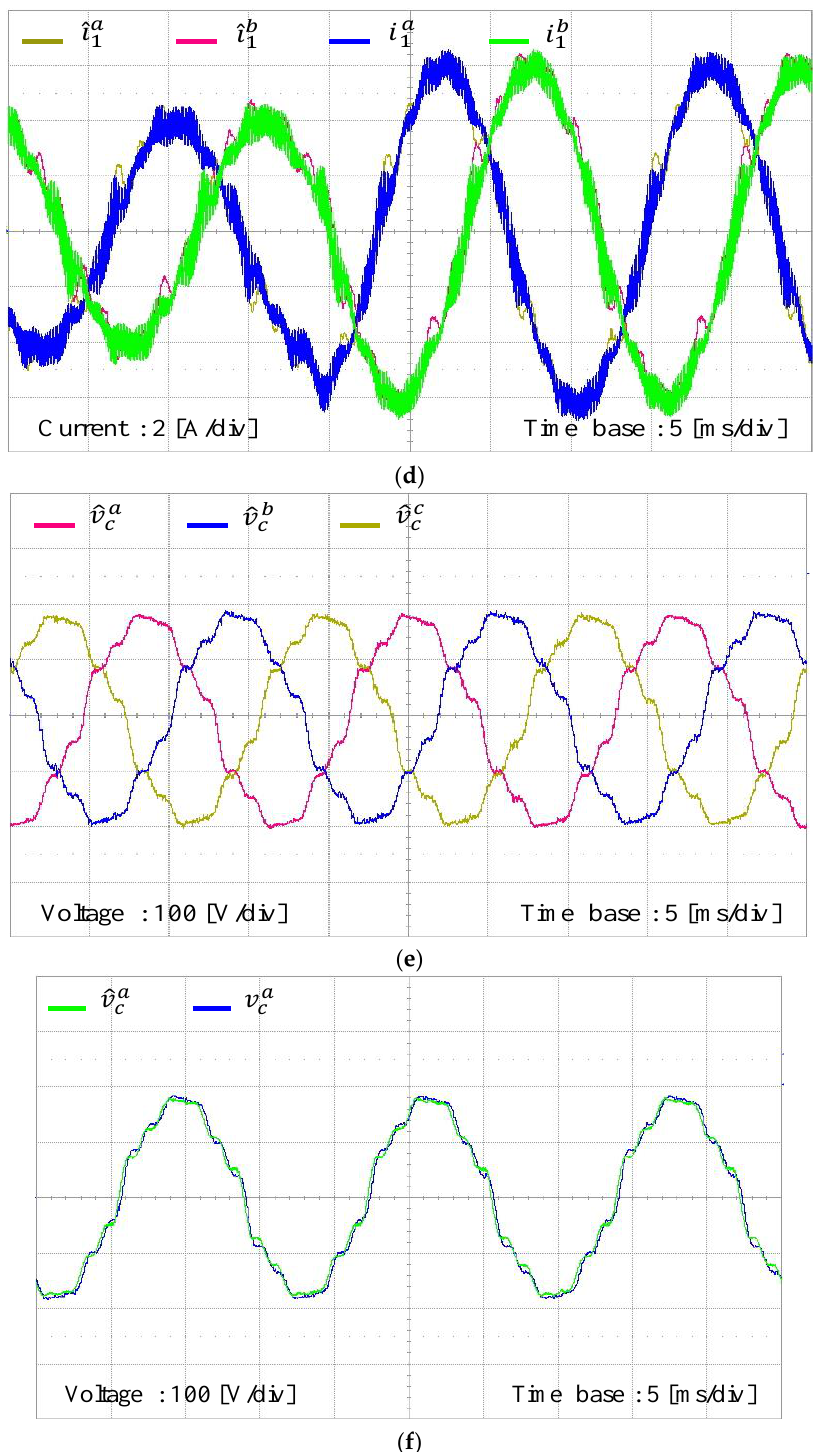
Figure 18. Experimental results for the estimating performance with the discrete-time full-state observer. ( a ) Estimating performance for grid-side three-phase currents; ( b ) comparison of the estimated grid-side currents and measured grid-side currents; ( c ) estimating performance for inverter-side three-phase currents; ( d ) comparison of the estimated inverter-side currents and measured inverter-side currents; ( e ) estimating performance for three-phase capacitor voltages; ( f ) comparison of the estimated capacitor voltage and measured capacitor voltage.